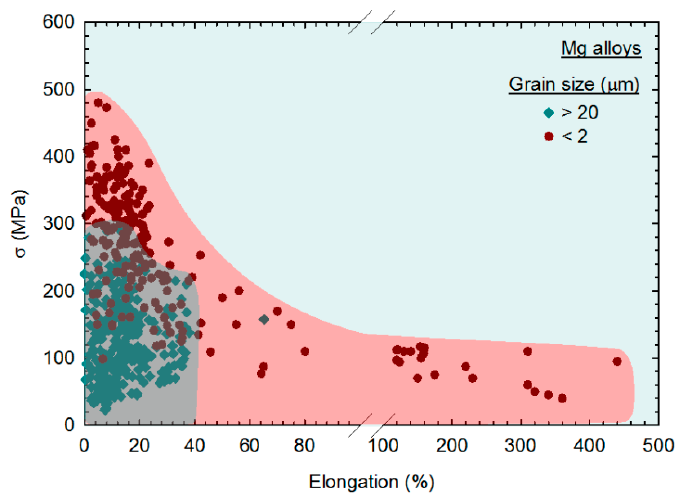
Figure 9. Flow stress ( σ ) of magnesium alloys plotted as a function of the elongation in tension for samples with different grain size ranges [44].